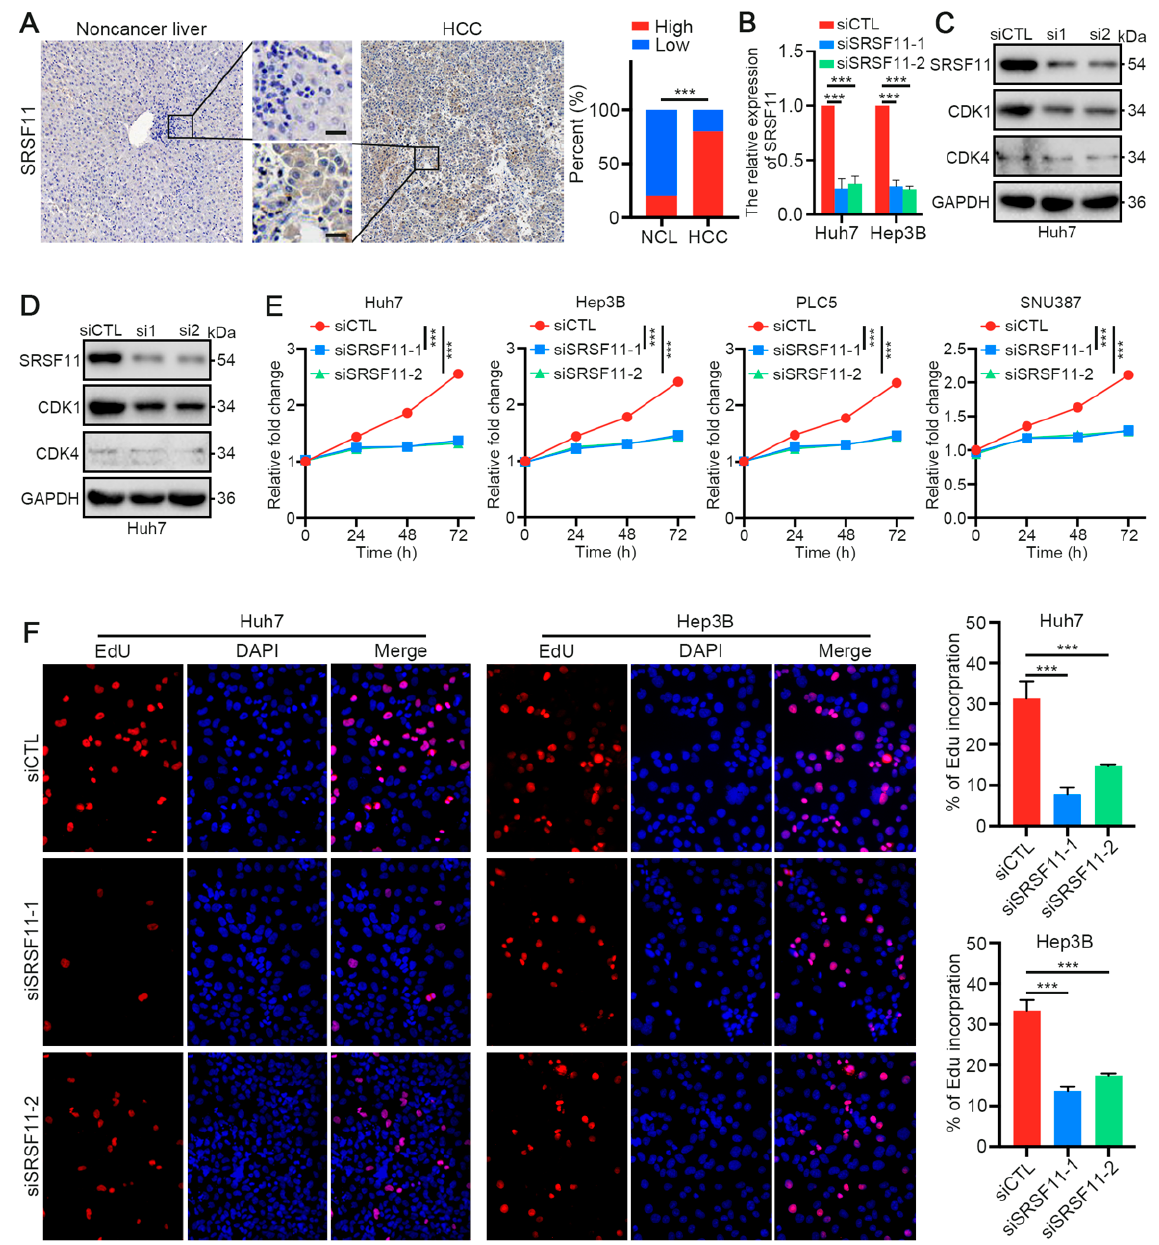
Figure 8. SRSF11 knockdown inhibits the CDK1-dependent cell proliferation in HCC. ( A ) Representative IHC images of SRSF11 in HCC and nontumor liver tissue from our HCC cohort. Scale bar denotes 50 μ m. ( B ) qRT-PCR and ( C , D ) western blotting for SRSF11, CDK1 and CDK4 in Huh7 or Hep3B cells transfected with SRSF11 siRNAs (siSRSF11) and control siRNA (siCTL), respectively. ( E ) CCK-8 assays for the indicated HCC cells transfected with siSRSF11 or siCTL over a 5-day period. ( F ) EdU assays for the indicated HCC cells transfected with siSRSF11 or siCTL for 48 h. The results are presented as the means ± SDs, and three independent experiments ( N = 3) were performed in triplicate. Student’s t- test was used for statistics. The asterisks represent the statistical p- value (*** p < 0.001).